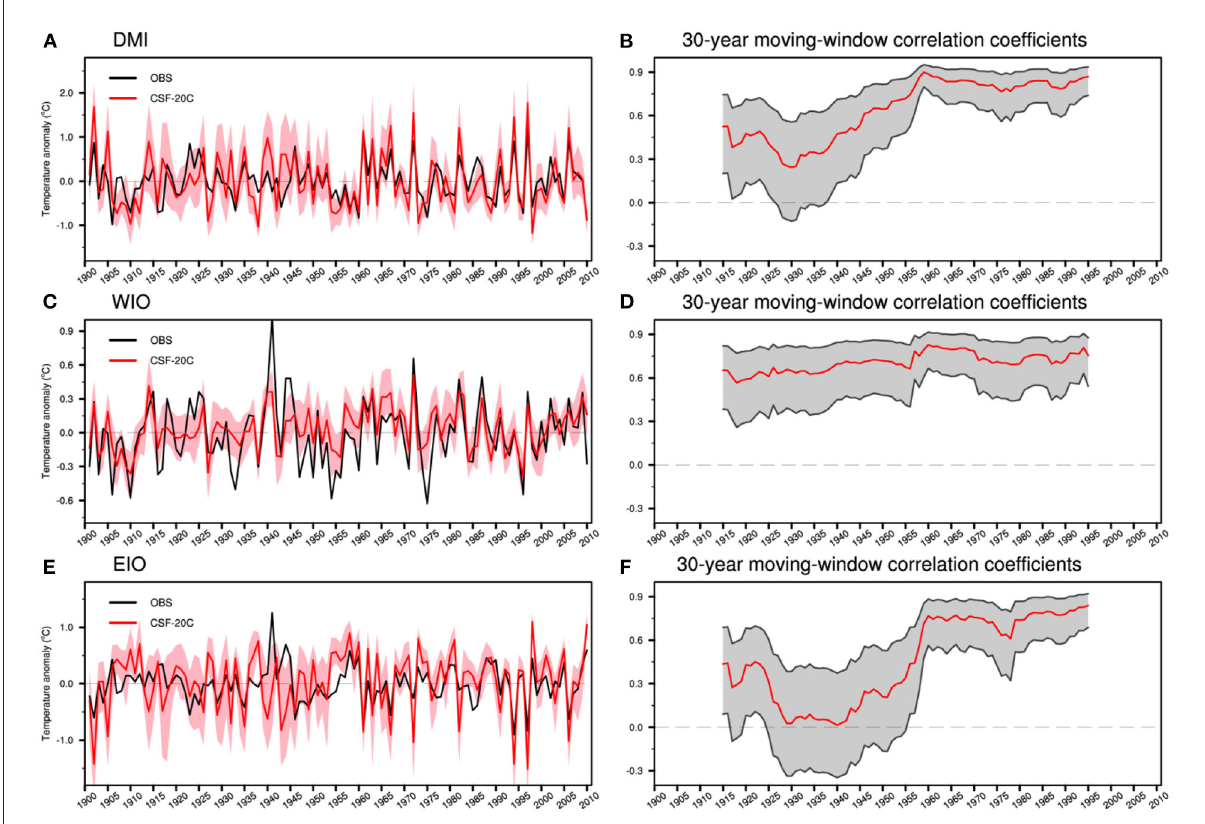
FIGURE1 Left: (A) The SON-mean Indian Ocean dipole mode index (DMI) in observations (black line) and the 1-month lead ensemble mean predictions from the Coupled Seasonal Forecasts of the 20th century (CSF-20C) (red line). The red shading indicates the ensemble spread. (C, E) as in (A) , but for predictions of the SON-mean western tropical Indian Ocean index (WIO) and the SON-mean tropical southeast Indian Ocean index (EIO). Right: the 30-year moving-window correlation coefficients between the ensemble mean prediction and the observations for (B) the SON-mean DMI, (D) the SON-mean WIO, and (F) the SON-mean EIO index. The correlation coefficients have been computed for 30-year windows moved across the period 1901–2010 by 1 year, and the correlations for each 30-year window are plotted at the central year. The gray-shaded bands in (B, D, F) indicate the 5–95% confidence